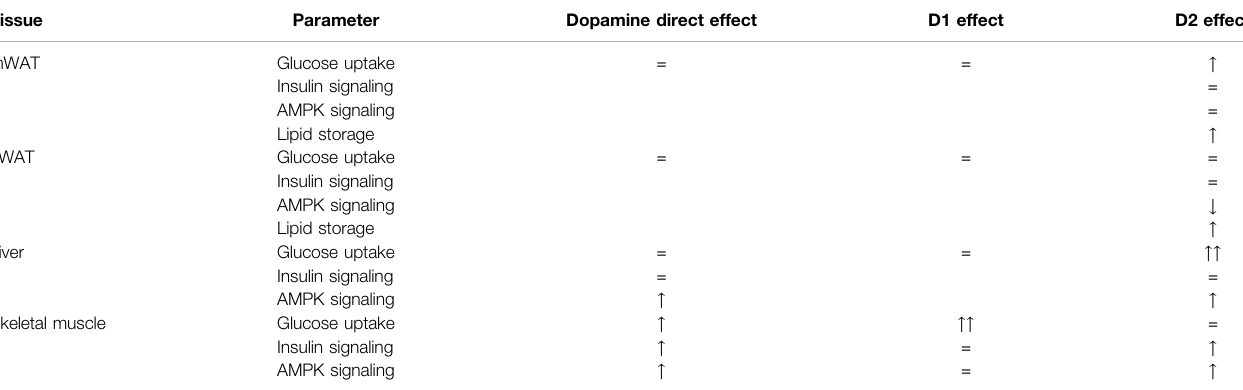
TABLE1| Summaryofthe fi ndingssupportingtheinvolvementofperipheraldopamineanditsreceptorsonglucoseuptake,insulinaction,AMPKsignaling,andlipidstorage. Peripheral dopamine stimulates glucose uptake in the liver, the skeletal muscle, and white adipose tissue (WAT). Dopamine directly acts in the same tissues to regulate InsR, Akt, and AMPK phosphorylation, being also involved in the regulation of metabolic functions in WAT, which can be an important factor for obesity-related diseases. Dopamine-directed effects in insulin-sensitive tissues are differentially modulated by D1 and D2 dopamine receptors.